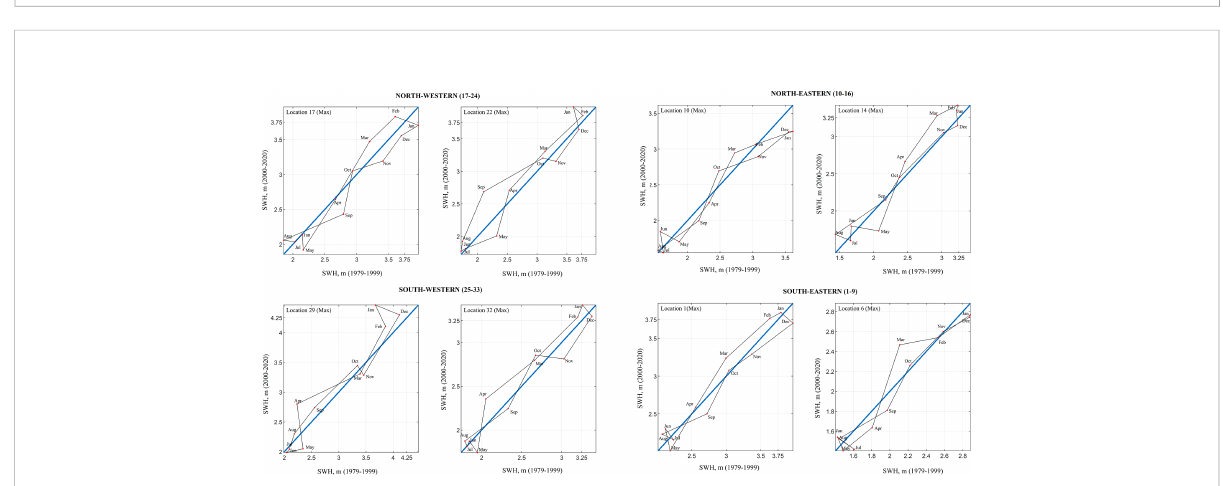
FIGURE 6 IPTA results for monthly mean SWHs during 42 years between 1979 and 2020.